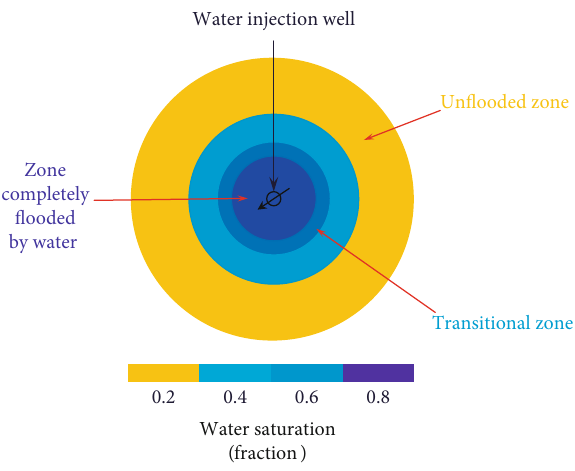
Figure 2: Schematic of fl uid distribution around a water injection well. Saturation gradients are established by water injection due to the di ff erent properties of injected water and reservoir fl uids. In the schematic, the residual oil saturation is 0.2; the irreducible water saturation is 0.2. The injection well is at the center of the circle. The dark blue is a zone completely fl ooded by water. The orange is an un fl ooded zone. The light blue is the transitional zones between the un fl ooded zone and the zone completely fl ooded by